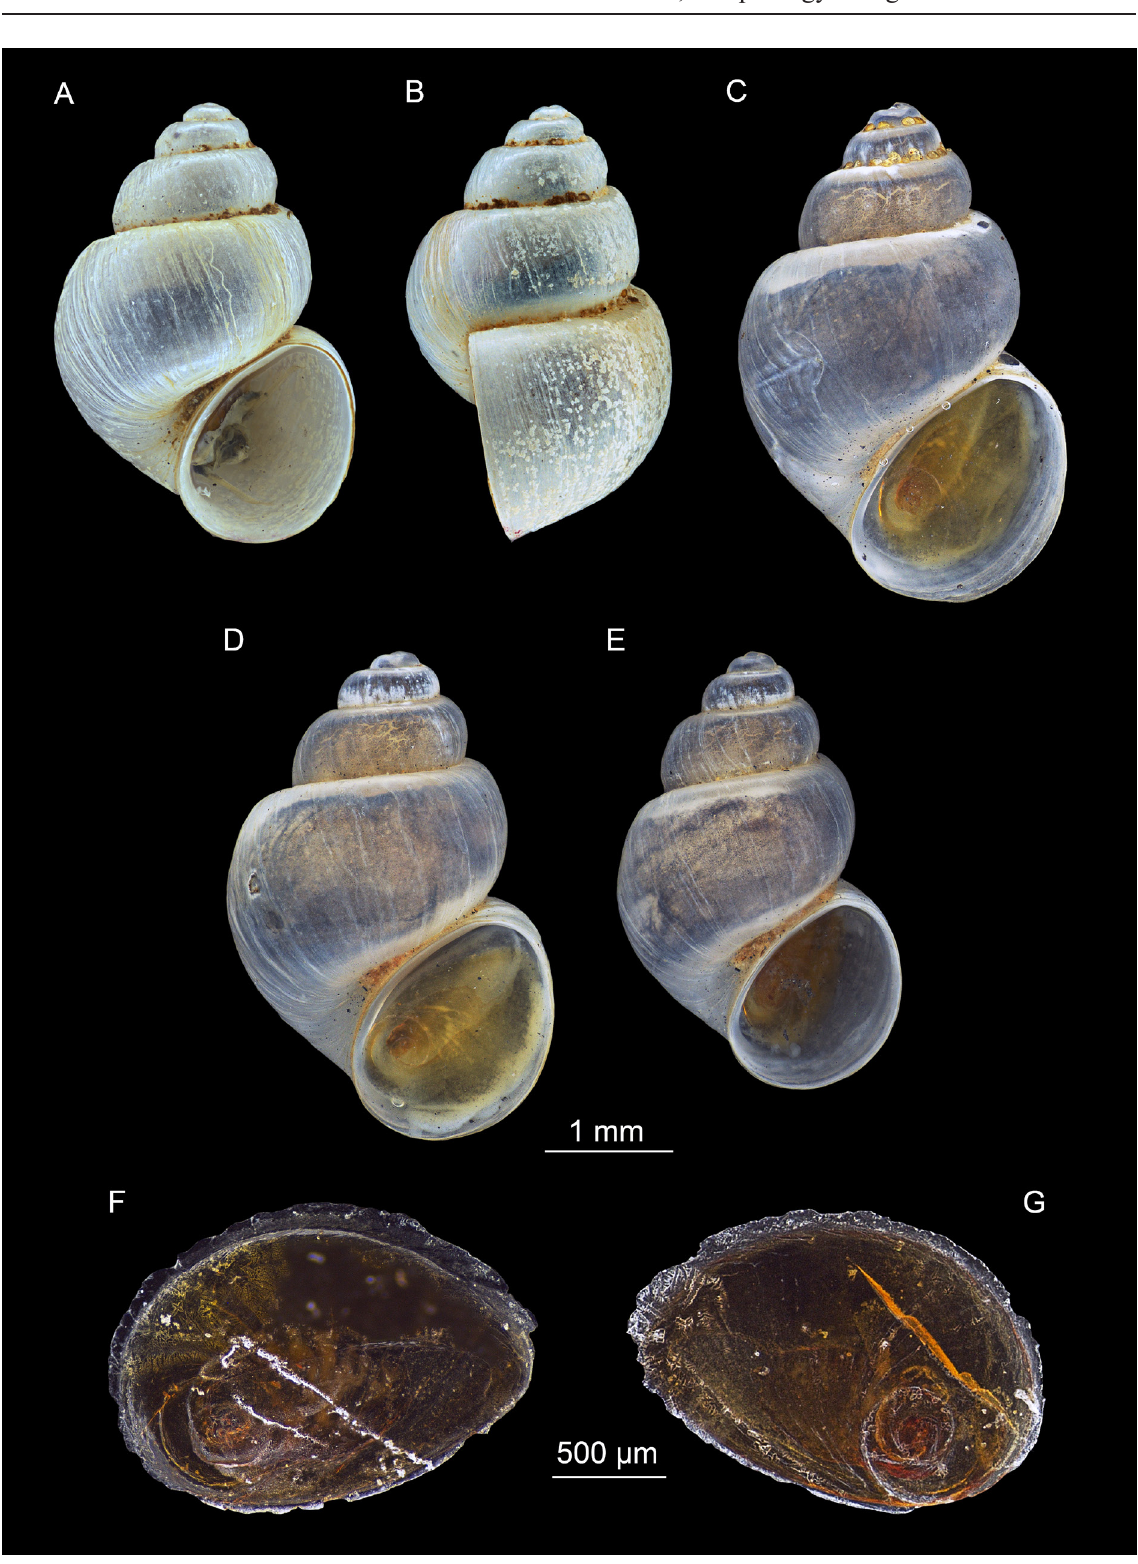
Fig. 17 . Shells and operculum of Mercuria egarensis Miller, García-Guerrero & Ramos sp. nov. A–B . Holotype (MNCN 15.05/200174H), frontal and lateral views. C–G . Paratypes (MNCN 15.05/94753). F . Operculum, inner side. G . Operculum, outer